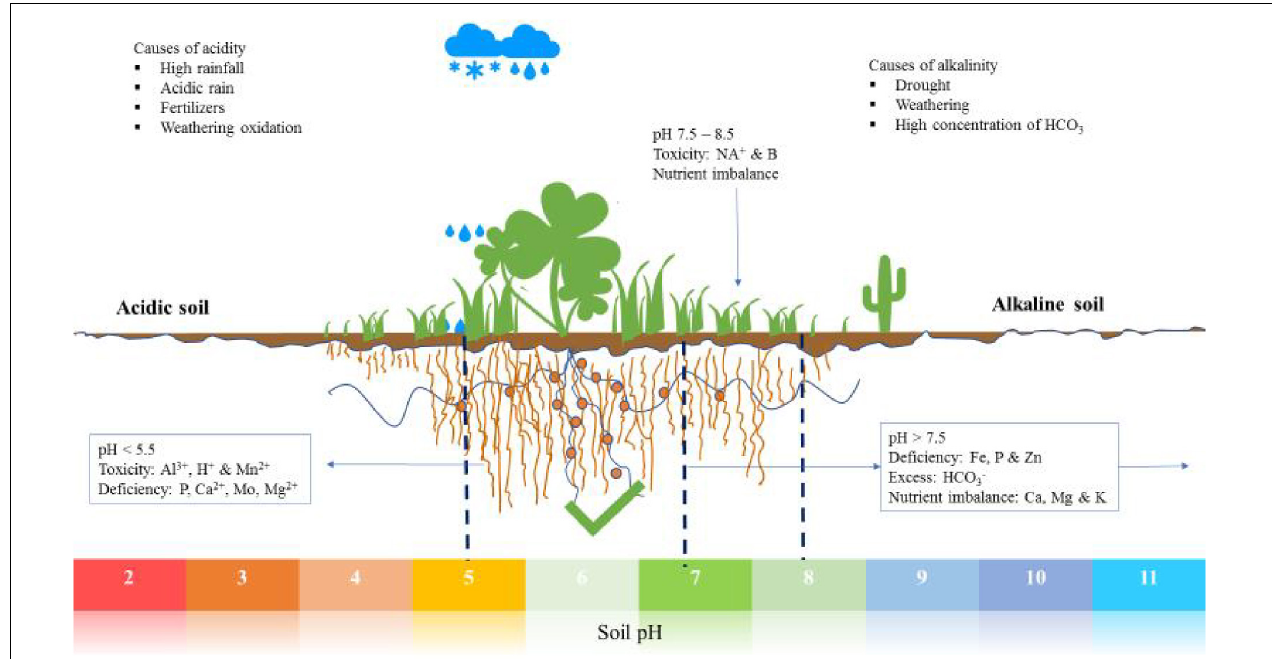
FIGURE 1 | An illustration of various soils with respect to pH, nutrient availability, deficiencies, and